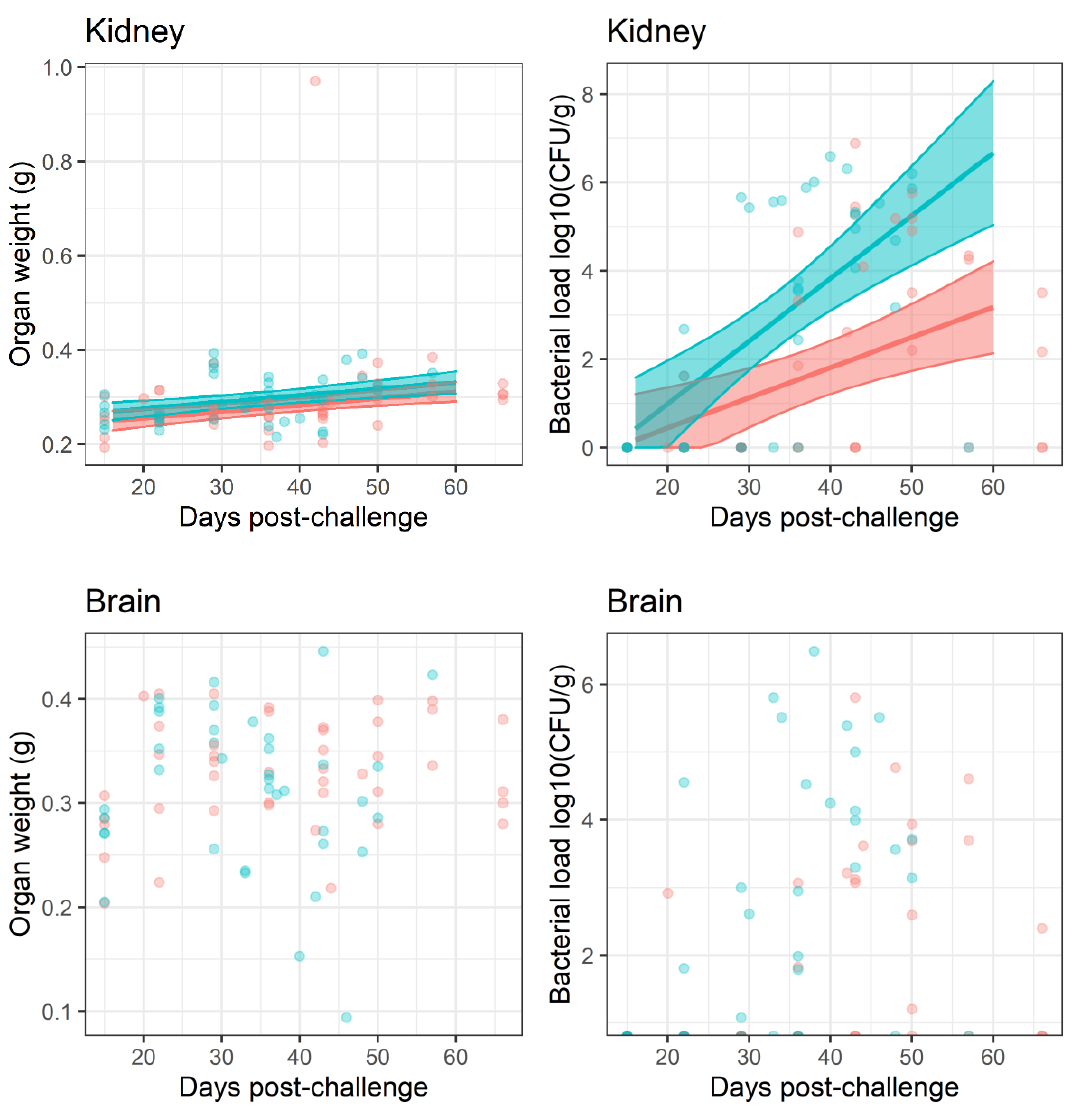
Figure 5. Comparison of the bacterial burden and organ weights of mice post-challenge. Mice were infected with a mean retained dose of 142 CFU of B. pseudomallei by the inhalational route and treated with finafloxacin (37.5 mg/kg) every 8 h or co-trimoxazole (78 mg/kg) every 12 h, orally, for 14 days, initiated at 24 h post-challenge. A group of animals were challenged and treated with the vehicle every 8 h. Each data point represents data from a single mouse. The shaded area represents the 95% prediction interval, the dots represent the original data points. Red–mice treated with finafloxacin, blue–mice treated with co-trimoxazole, grey–indicates overlapping data from both antibiotics. Data was split by organ: spleen, lung, liver, kidney and brain. Supplemental Figure S6 is a diagnostic plot for this analysis.